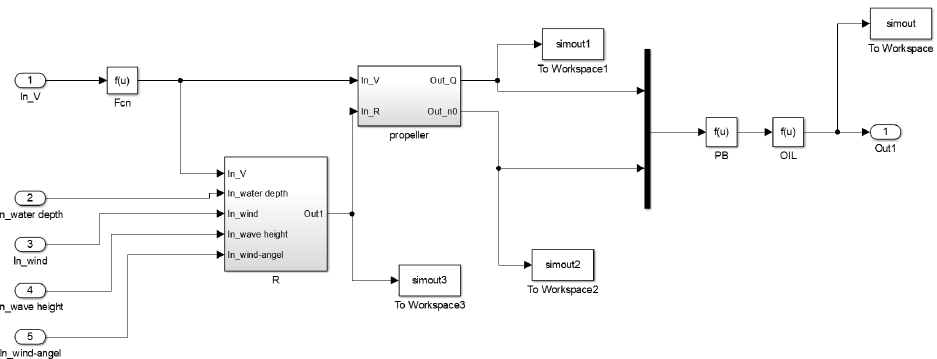
Figure 8. Fuel consumption prediction model of the target ship.